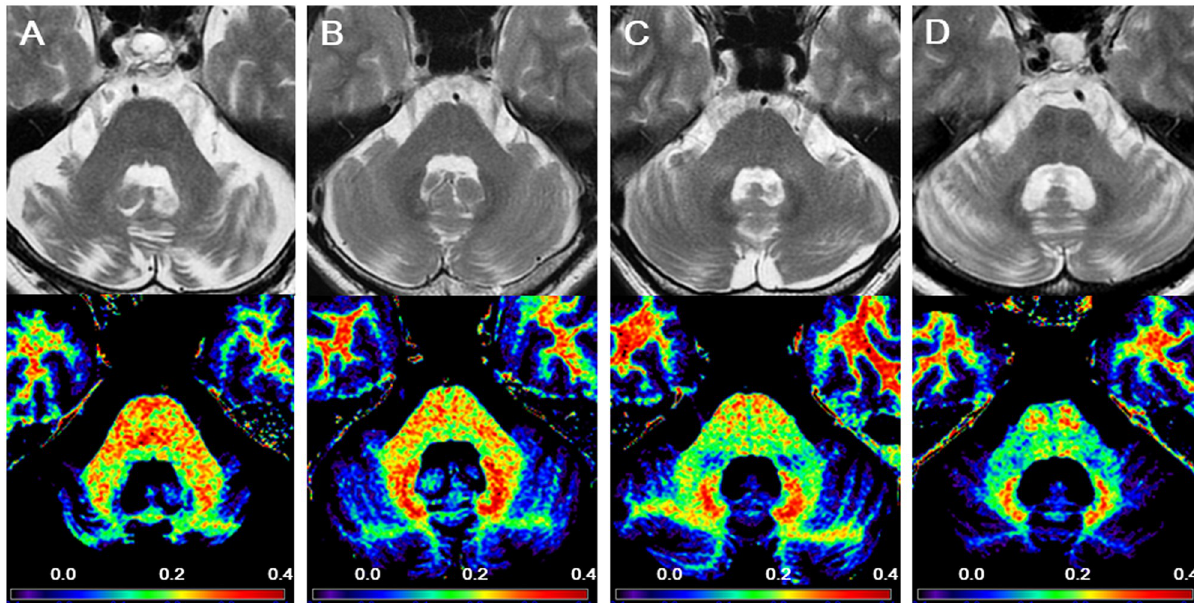
Fig 2. Typical Middle Cerebellar Peduncle (MCP) hyperintensities and Hot Cross Bun (HCB) sign on magnetic resonance imaging in cerebellar- type multiple system atrophy (MSA-C) and spinocerebellar ataxia type 3 (SCA3) and 6 (SCA6). (A) Grade 0 (negative) HCB sign and absent MCP hyperintensities in a 74-year-old man with a SCA6 disease duration of 2.3 years. (B) Grade 1 HCB sign and absent MCP hyperintensities in a 66-year- old man with SCA3 and a disease duration of 3.8 years. (C) Grade 1 HCB sign and MCP hyperintensities in a 57-year-old man with MSA-C and a disease duration of 0.9 years. (D) Grade 2 HCB sign and MCP hyperintensities in a 62-year-old woman with MSA-C and a disease duration of 2.8 years. Upper row: axial T2-weighted images. Lower row: standardized T1-weighted/T2-weighted ratio maps.